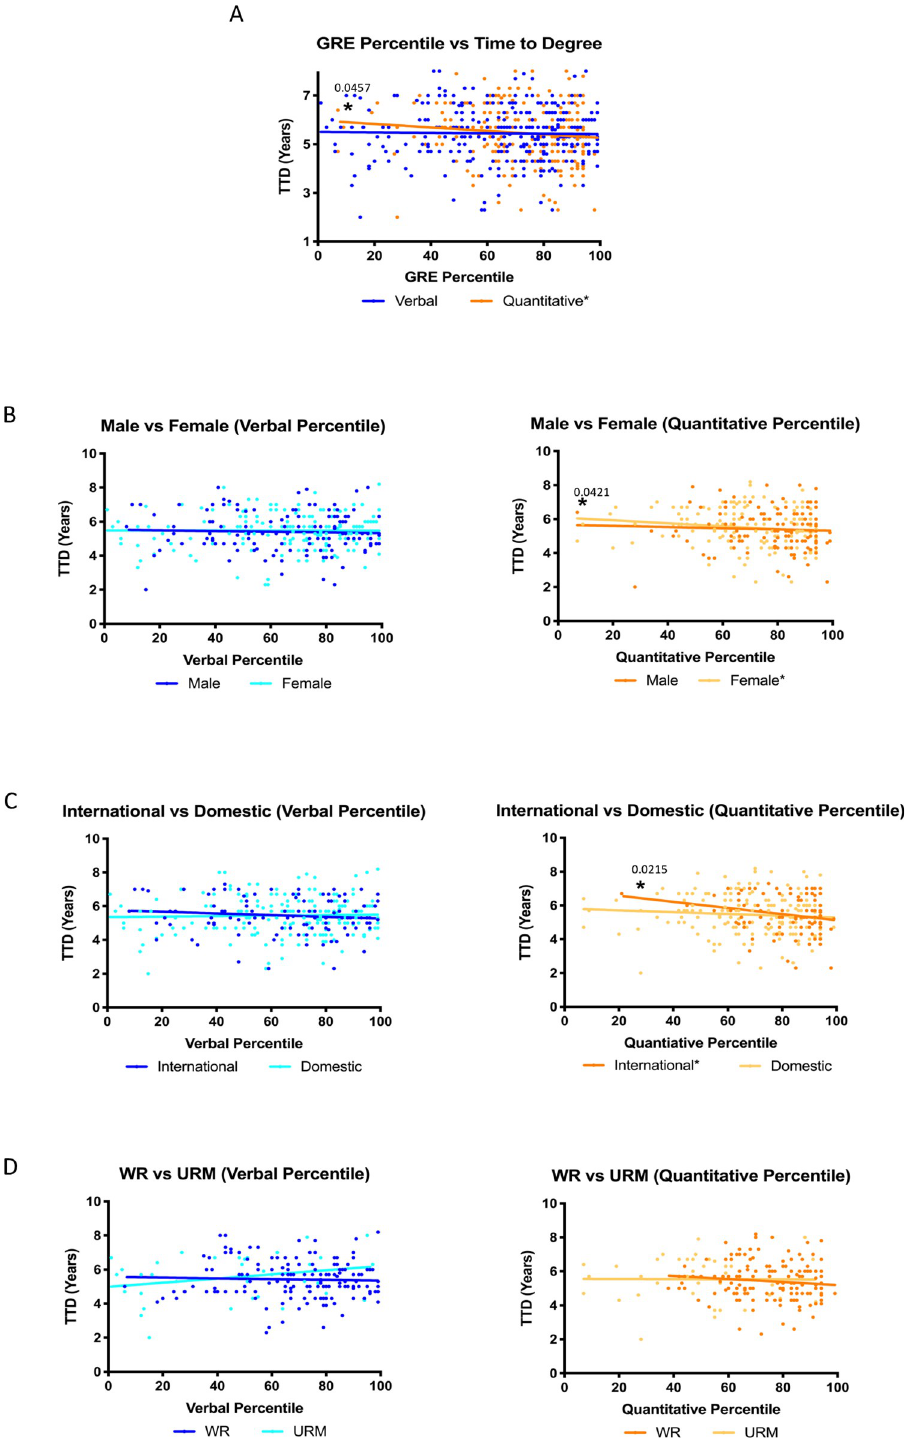
Fig 5. Quantitative GRE percentiles are significantly correlated to the time it takes students to graduate with a PhD. Time to degree is plotted on a scatterplot as a function of GRE percentile (A). The data was further divided on a basis of gender (B), citizenship (C), and representation